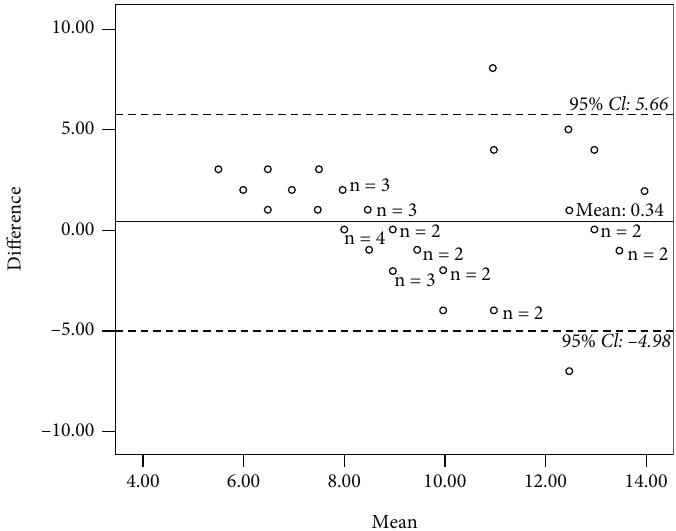
Figure 2: Bland-Altman plot for interrater reliability